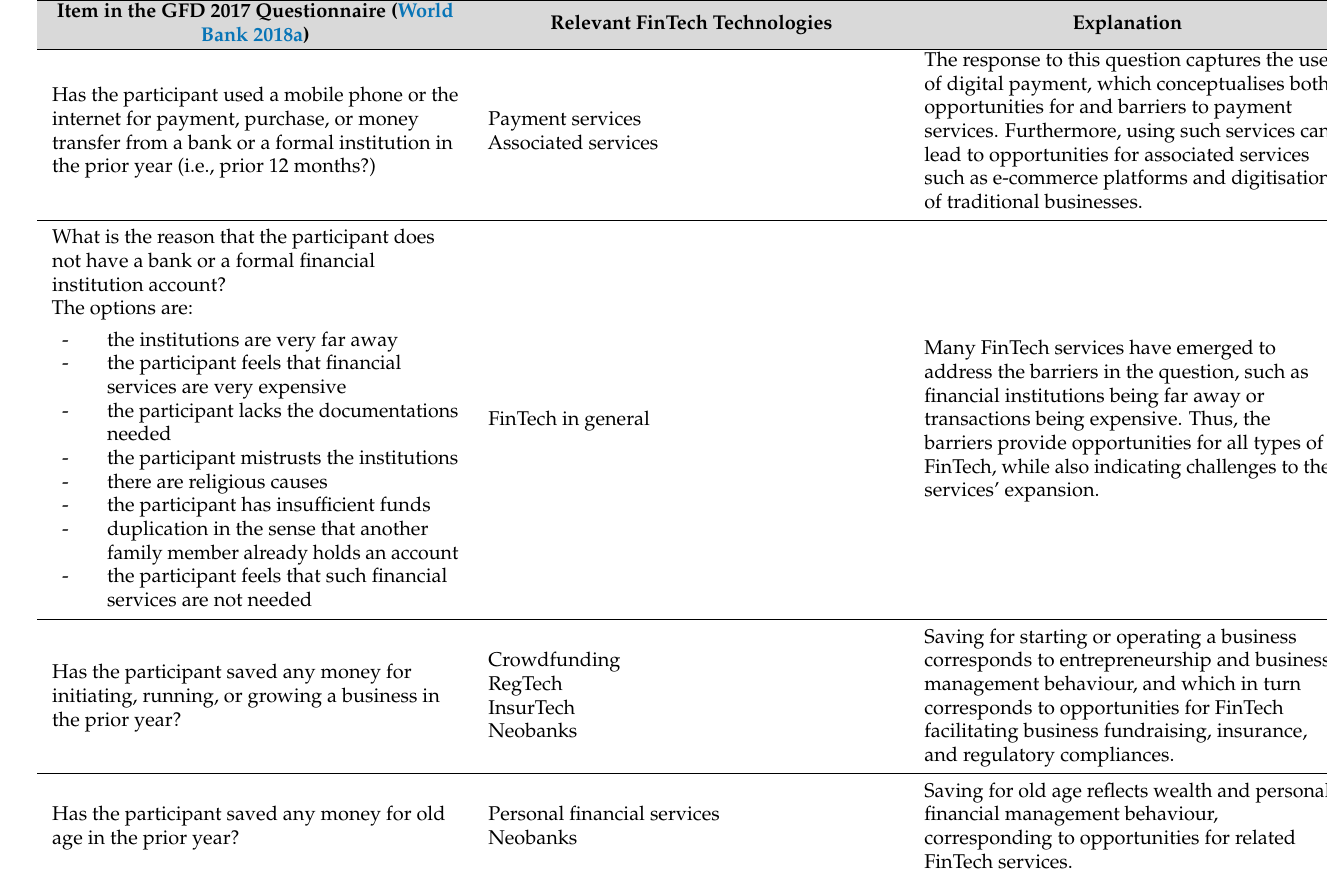
Table 1. Questions and items conceptualised in this research to reflect opportunities and barriers for